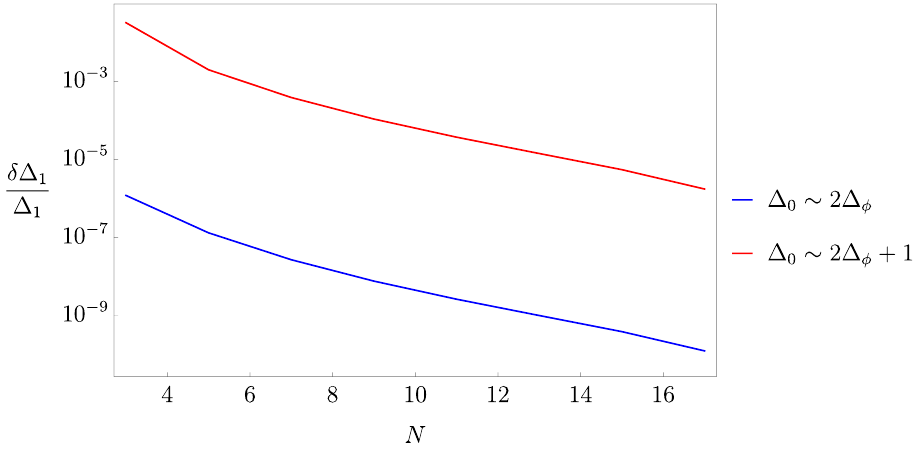
Figure 8 . Convergence of OPE maximization. Shown are the relative errors in the determination of (cid:1) (as compared to its value for N = 19), for two distinct values of (cid:1) 1 bosonic and fermionic points. Although the initial error is smaller in the former (since we are using the bosonic basis), the rate of convergence is the same in either case and compatible with a 1 =N 6